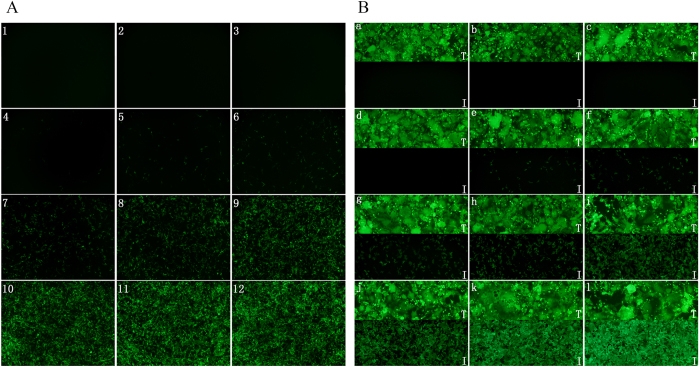
Selection of suitable range of antiviral drug concentration by ZsGreen reporter.(A) Effect of serial dilution of Zidovudine (a representative of NRTIs and NNRTIs) on protein expression of lentivirus infected 293A cells. 1, 10 MOI + 333.333 μM/L; 2, 10 MOI + 111.111 μM/L; 3, 10 MOI + 37.037 μM/L; 4, 10 MOI + 12.345 μM/L; 5, 10 MOI + 4.115 μM/L; 6, 10 MOI + 1.371 μM/L; 7, 10 MOI + 0.457 μM/L; 8, 10 MOI + 0.152 μM/L; 9, 10 MOI + 0.0508 μM/L; 10, 10 MOI + 0.0169 μM/L; 11, 10 MOI + 0.0056 μM/L; 12, 10 MOI. (B) Effect of serial dilution of Lopinavir (a representative of PIs) on lentivirus production. a, 1371 nM/L; b, 457 nM/L; c, 152 nM/L; d, 50.8 nM/L; e, 16.9 nM/L; f, 5.6 nM/L; g, 1.88 nM/L; h, 0.627 nM/L; i, 0.209 nM/L; j, 0.06969 nM/L; k, 0.02323 nM/L. T, Transfection of 293FT cells with 3 plasmids of packaging system in the presence of different concentration of drug; I, Infection of 293A cell with 50 μl lentivirus supernatant from the paired Transfection.